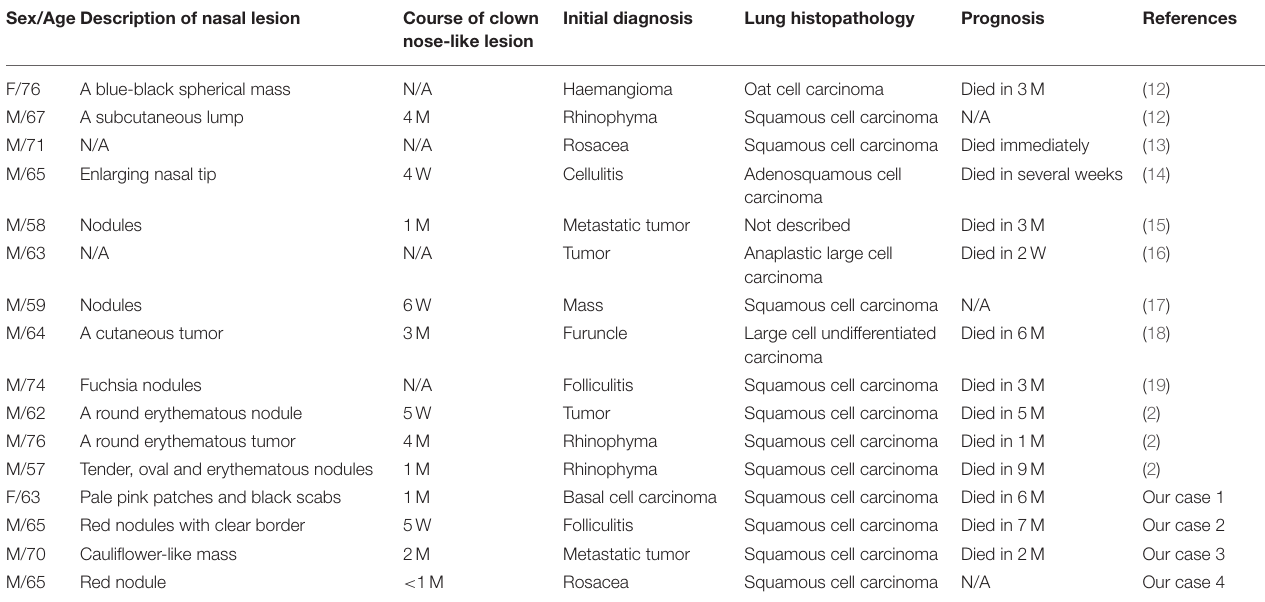
TABLE 1 | Nasal tip cutaneous metastasis from lung